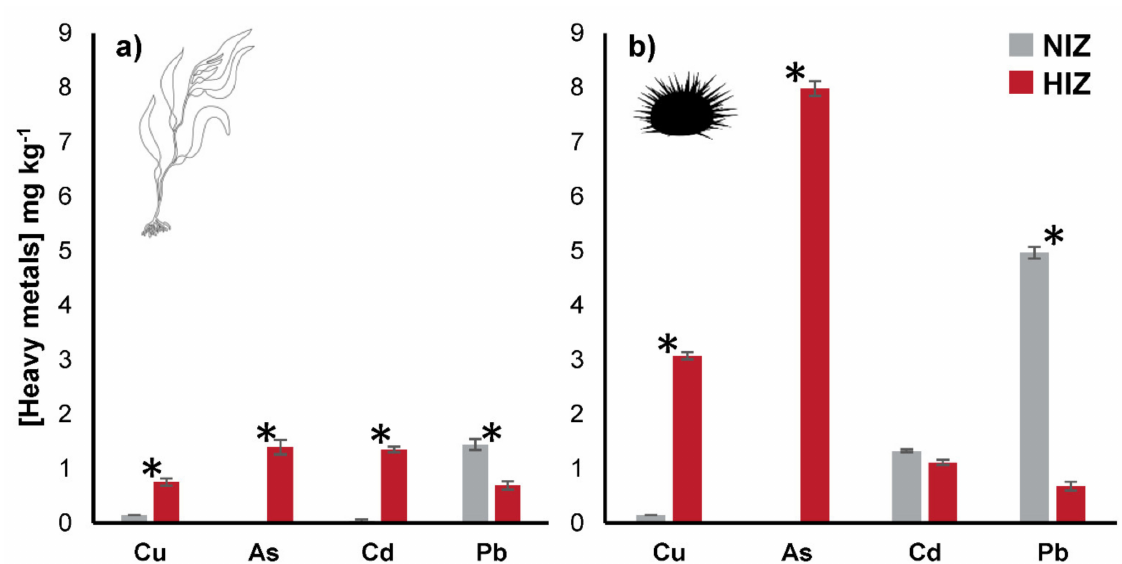
Figure 4. Concentrations of Cu, As, Cd, and Pb in ( a ) M. pyrifera and ( b ) T. niger tissues collected from Algarrobo (NIZ) and Caleta Horc ó n (HIZ). Asterisks represent significant differences between the treatments of the same matrix for each metal, ANOVA ( p < 0.05). NIZ = non-impacted zone, HIZ = highly impacted